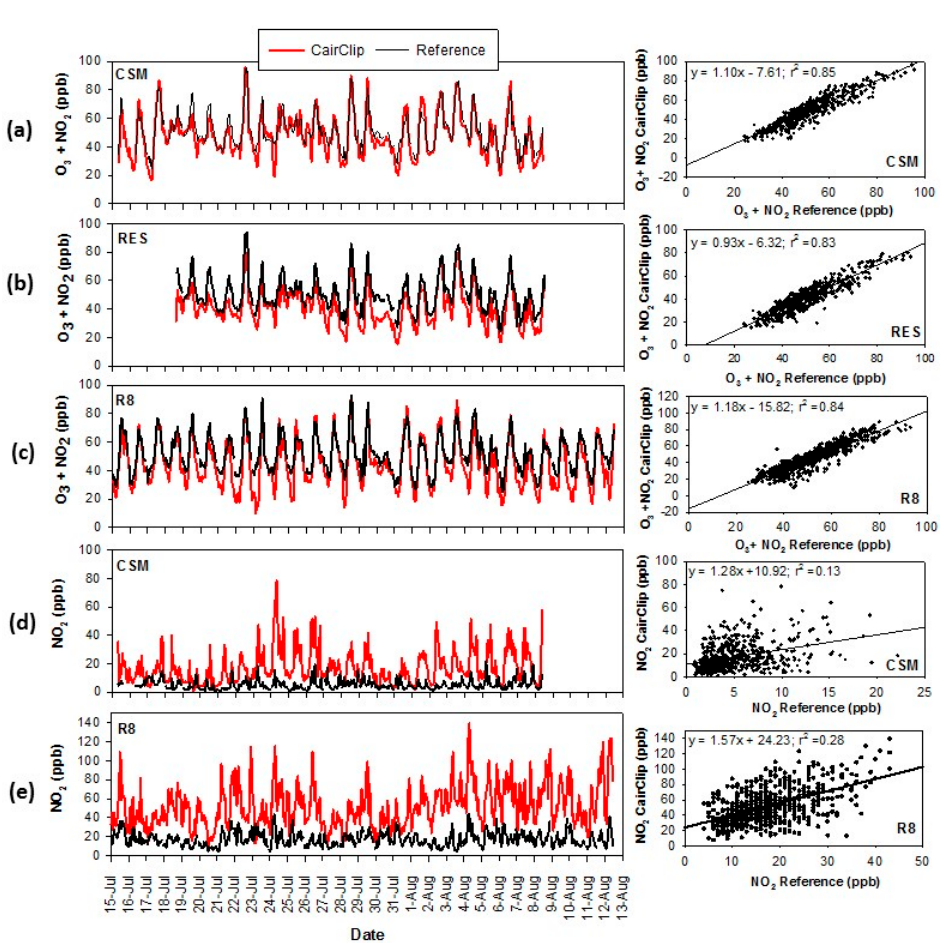
Figure 7. Measurements from the citizen science-operated sites compared to nearby reference data in the Denver campaign for the ( a ) to ( c ) CairClip O 3 /NO 2 sensor and ( d ) to ( e ) CairClip NO 2 sensor. The CairClip NO 2 sensor consistently reported higher NO 2 concentrations compared to the reference NO 2 data (Table 3 and Figure 7). At the CSM and R8 sites, the diurnal patterns appeared to